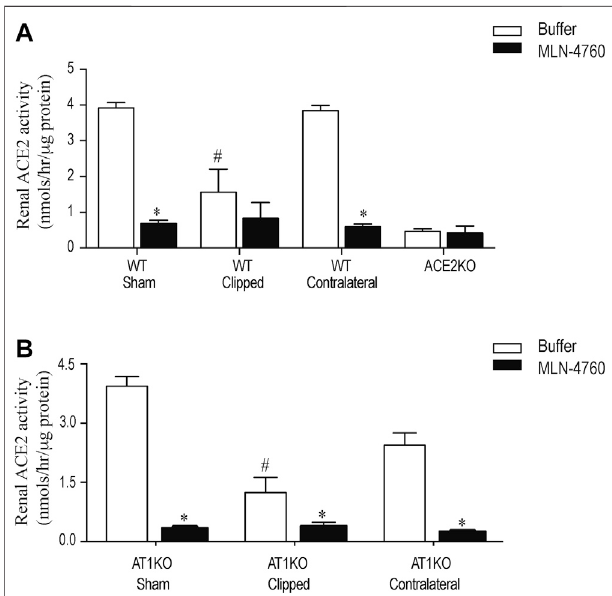
FIGURE7| Effectofrenovascular hypertension on renalACE2 activity in WT and AT1KO mice after 2 weeks of 2K1C Goldblatt surgery. Renal ACE2 activity was measured using 20 µg of kidney protein and fl uorogenic ACE2 substrate inpresence and absenceoftheACE2 inhibitor MLN-4760. (A) ACE2 activity in the sham, clipped and contralateral kidneys of WT mice. (B) ACE2 activity in the sham, clipped and contralateral kidneys of AT1KO mice. One-way ANOVA showed a signi fi cant decreased in renal ACE2 activity in clipped kidney of2K1C mice compared to sham and contralateral kidney * p < 0.001vs.buffer,# p < 0.05vs.shamkidney.Eachbarrepresentsmean ± SEM (n (cid:2) 6 – 8).